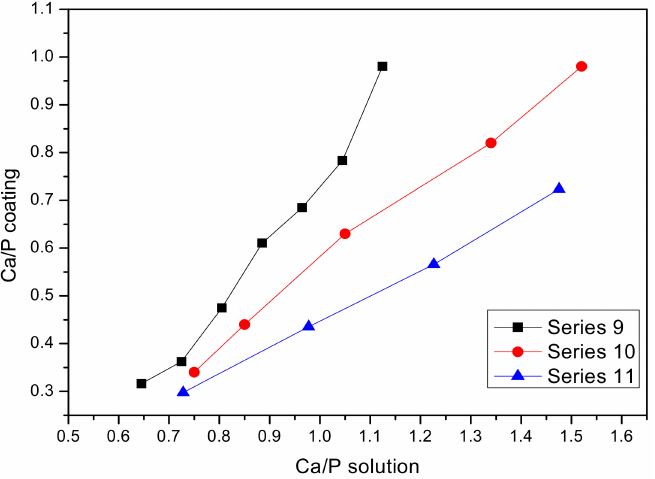
Figure 3. Relationship between the Ca/P ratio in the coating and that in the solution (for the electrolytes of series 9, 10, and